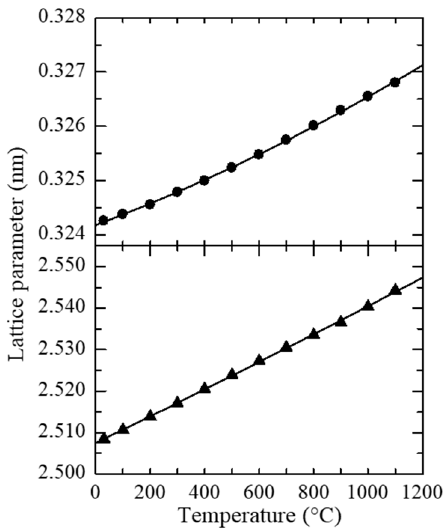
Figure 3. Temperature dependence of the lattice parameters of a - and c -axes for SCAM crystal. The fitted lines with quadratic functions are also shown in this figure as a guide for your eyes. Table 1. Obtained lattice parameters of a - and c -axes for SCAM single crystal with various temper- atures. The standard errors of the last digit are also shown in brackets.